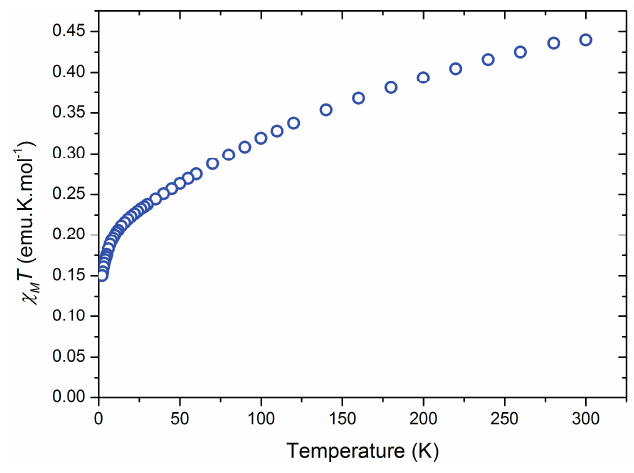
Figure 6. Variation of the product of the molar magnetic susceptibility product ( χ M T , cm 3 ·Kmol − 1 ) with temperature (K) of 2 .